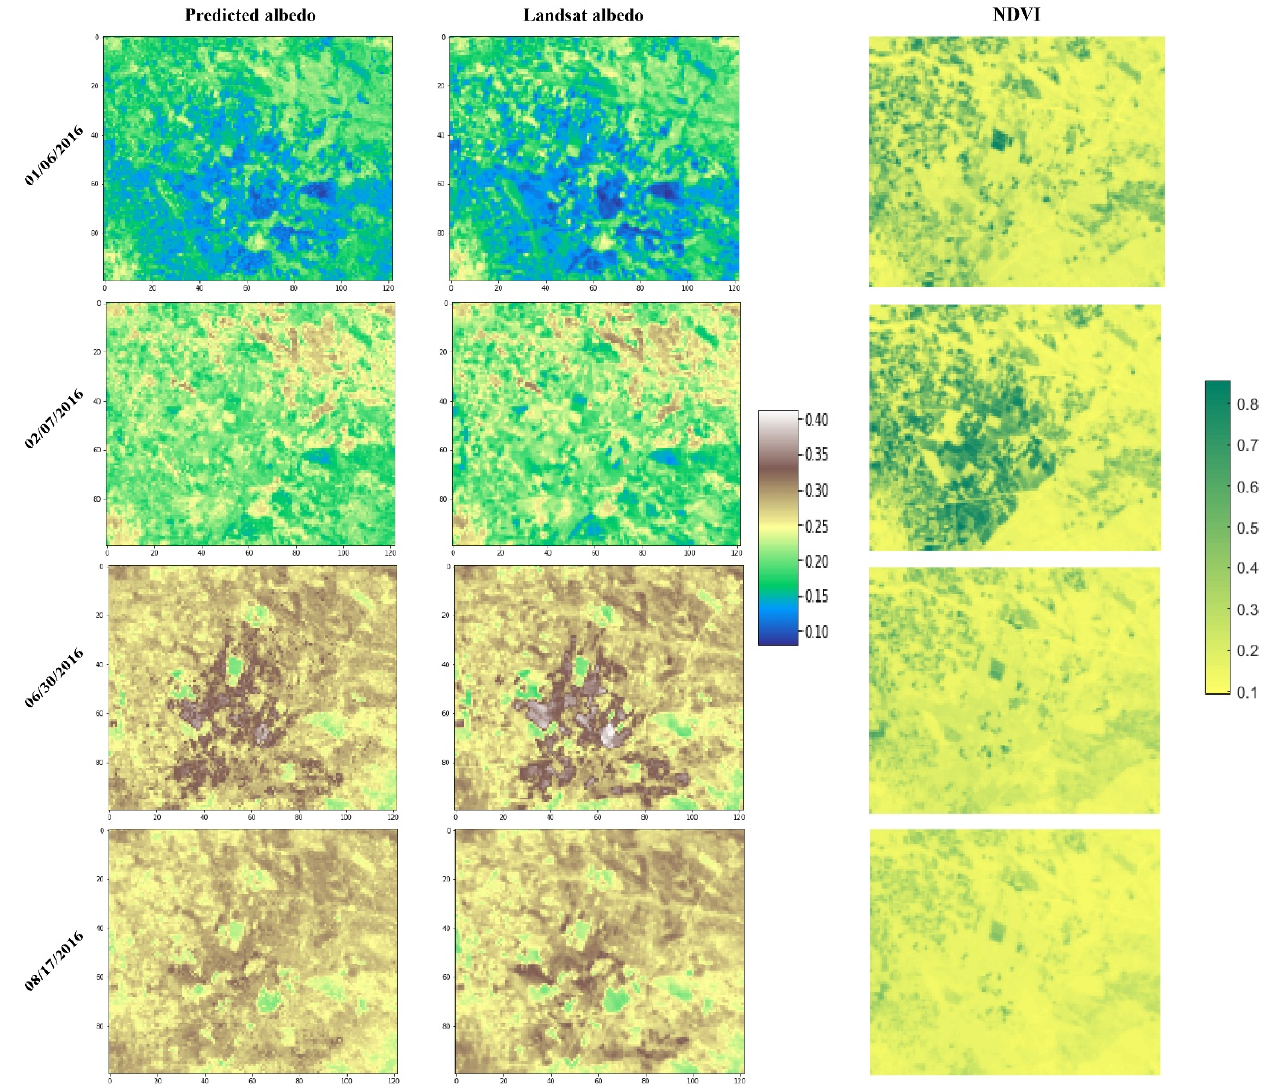
Figure 7. Maps of the surface albedo by random forest algorithm compared to the Landsat reference albedo imagery on the four cloudless dates over R3 area. NDVI maps were also presented.